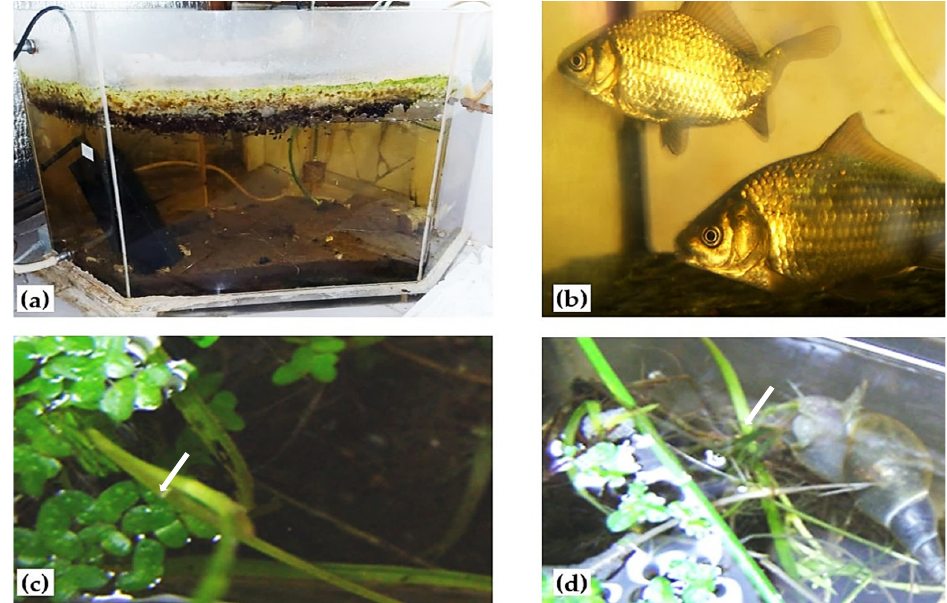
Figure 6. The general appearance of the aquarium module ( a ) and its inhabitants, such as crucian carp ( Carassius carassius ) ( b ), Tubifex worms ( c ), and snail ( d